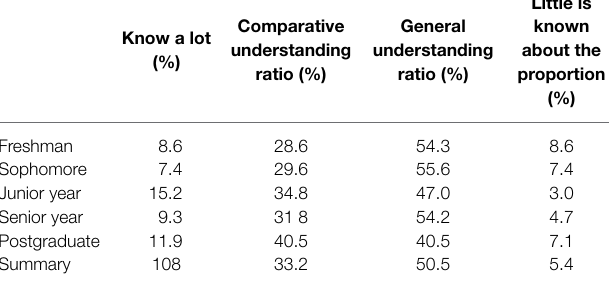
TABLE 2 | Knowledge of the concept of justice data